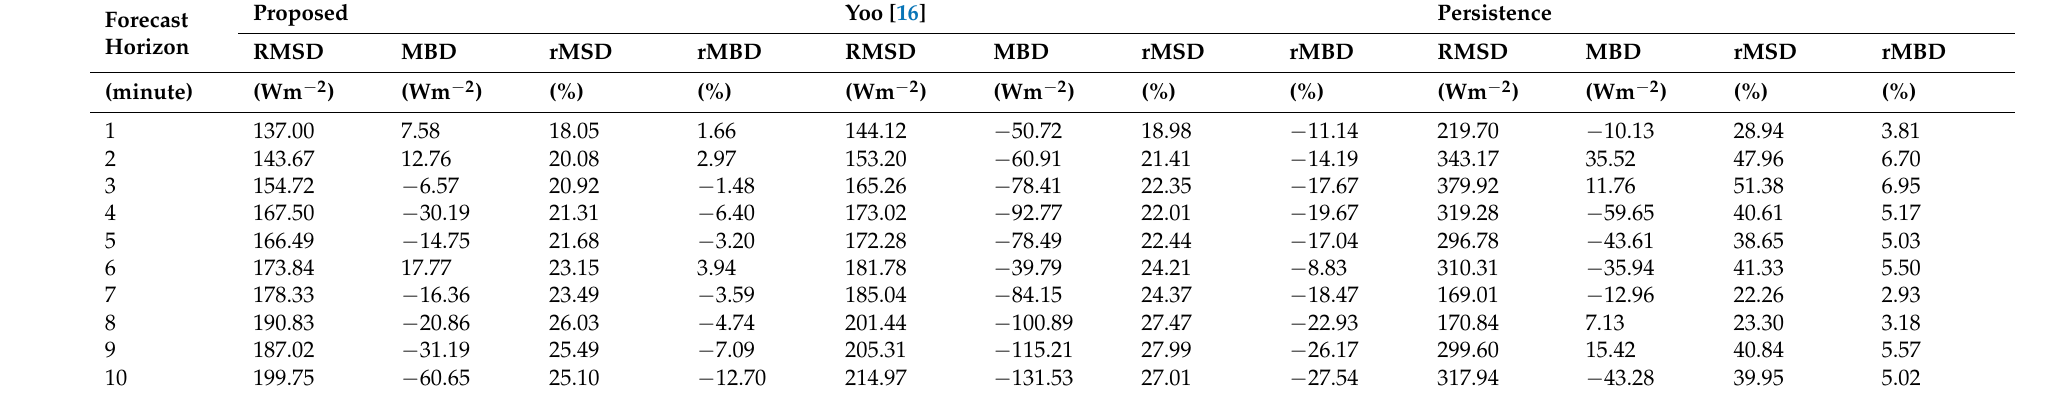
Table 3. Evaluation metrics of forecast performance between the proposed, the Yoo, and the persistence models for partly cloudy days. Forecast